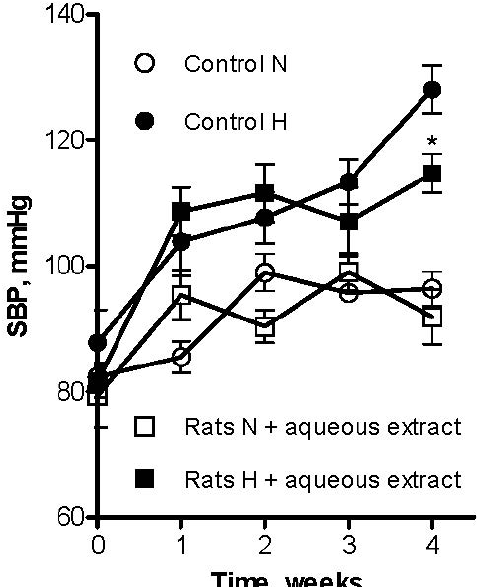
Figure 5. Effect of long-term oral administration of aqueous extract of black cherry fruits (300 mg/Kg/day) on systolic blood pressure (SBP) in L-NAME (30 mg/Kg/day) induced hypertensive rats (H), and normotensive rats (N). Control indicates rats receiving only tap water. Values are mean ± SEM ( n = 6 rats for each group). * p ˂ 0.05 vs .